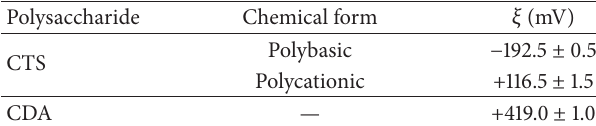
Table 1: Surface potential of the solid fibrous matrices. Polysaccharide